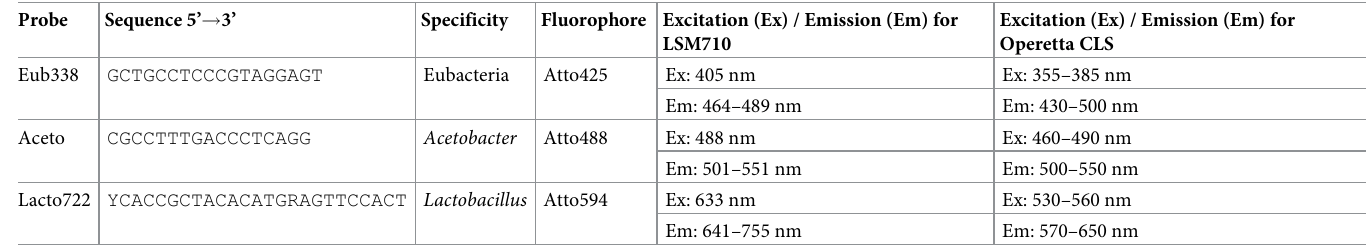
Table 1. FISH probes used in the present